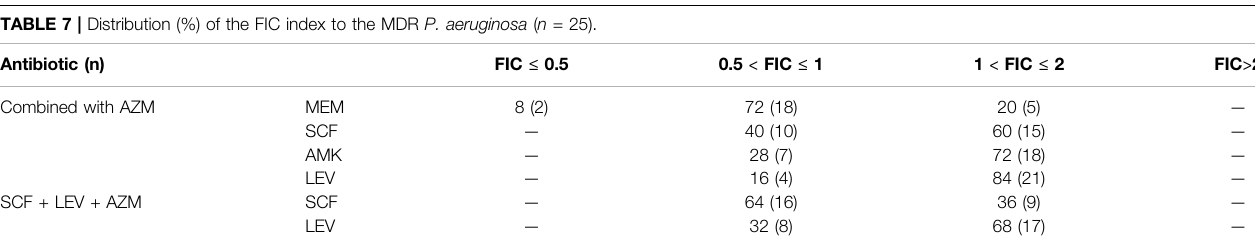
Abbreviations: FIC, fractional inhibitory